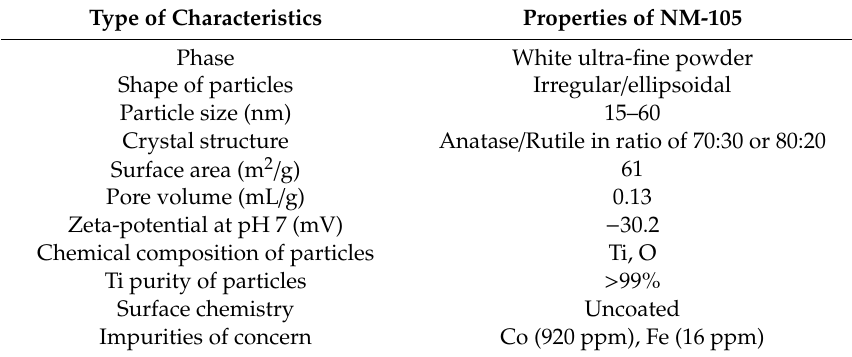
Table 1. Summary of primary physical and chemical properties of the used TiO 2 NPs NM-105